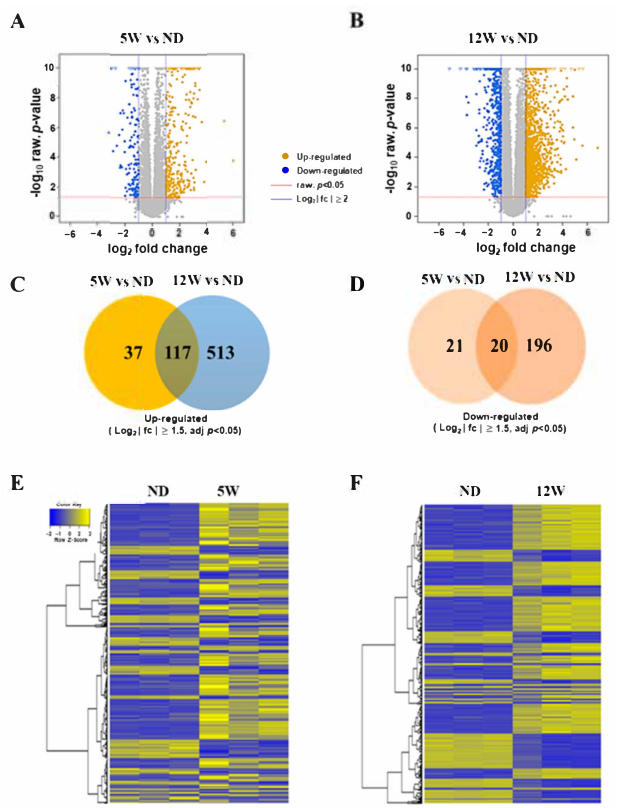
Figure 4. Differentially expressed mRNAs in the renal cortex of the DN rat model. ( A ) Volcano plot for comparison between 5-week-HFD group and normal-diet (ND) group (5 W vs. ND). In the right of the graph, yellow color is indicative of the up-regulated expressed gene (log 2 FC > 2 and FDR < 0.05); in the left of graph, blue color is indicative of the down-regulated gene (log 2 FC > 2 and FDR < 0.05). The gray points indicate mRNAs that were not statistically significant (FDR > 0.05). ( B ) Volcano plot for comparison between 12-week-HFD group and ND group (12 W vs. ND). ( C ) Up-regulated differentially expressed genes (log 2 FC > 1.5, FDR < 0.05) in the comparisons between 12 W vs. ND and 5 W vs. ND. ( D ) Down-regulated differentially expressed genes (log 2 FC > 1.5, FDR < 0.05) in the comparisons between 12 W vs. ND and 5 W vs. ND. ( E , F ) Differentially expressed genes (FDR < 0.05) in diabetic rat and normal tissue were analyzed using hierarchical clustering. Each row represents a single mRNA and each column represents one tissue sample. FC, fold change; FDR, false discovery rate; mRNA, messenger RNAs; ND, normal diet; HFD, high-fat diet; 5 W, 5 weeks; 12 W, 12